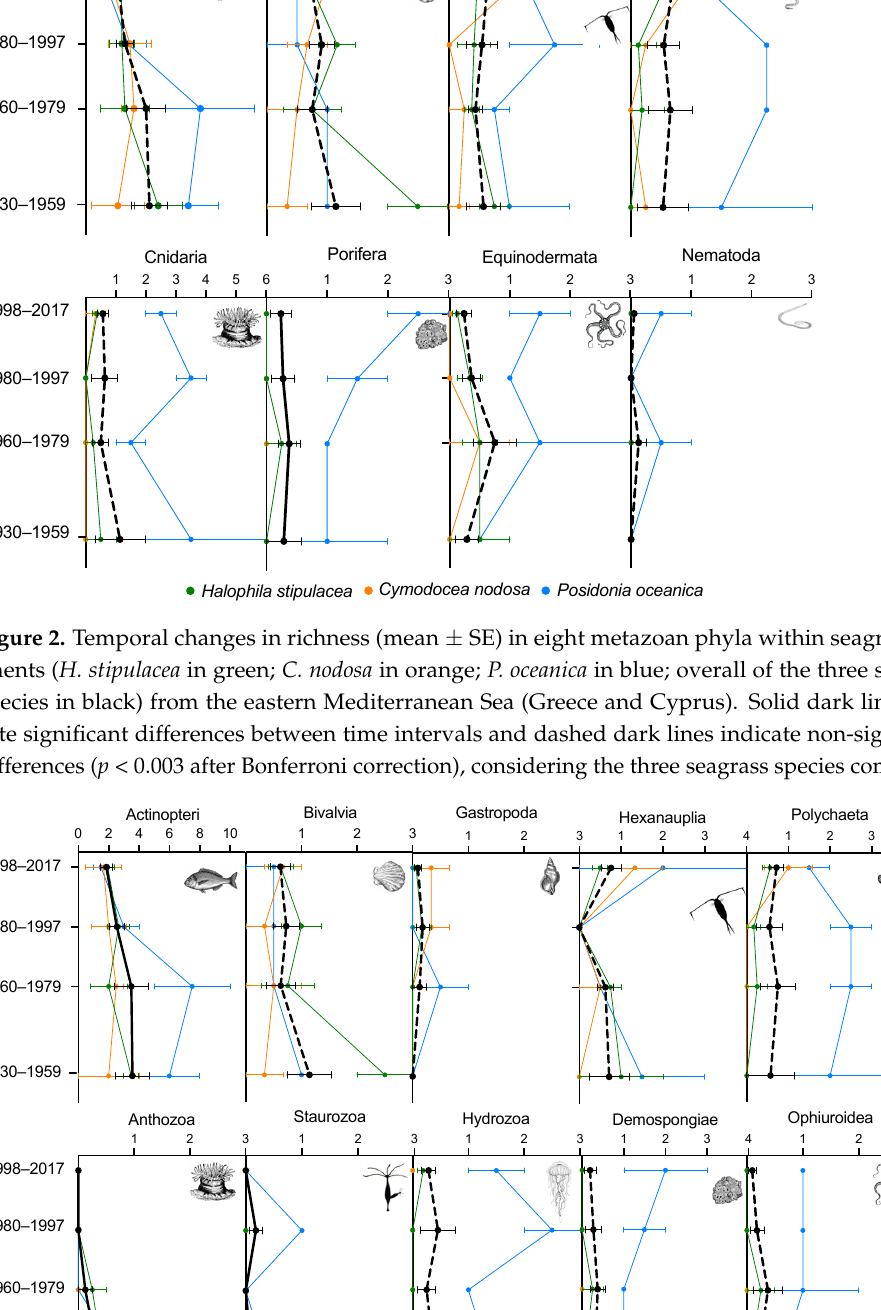
(Figure 4). All Cnidarian orders ( n = 7) were present in P. oceanica (except for Siphono- phores) and absent from C. nodosa and only three Cnidarian orders were present in H.